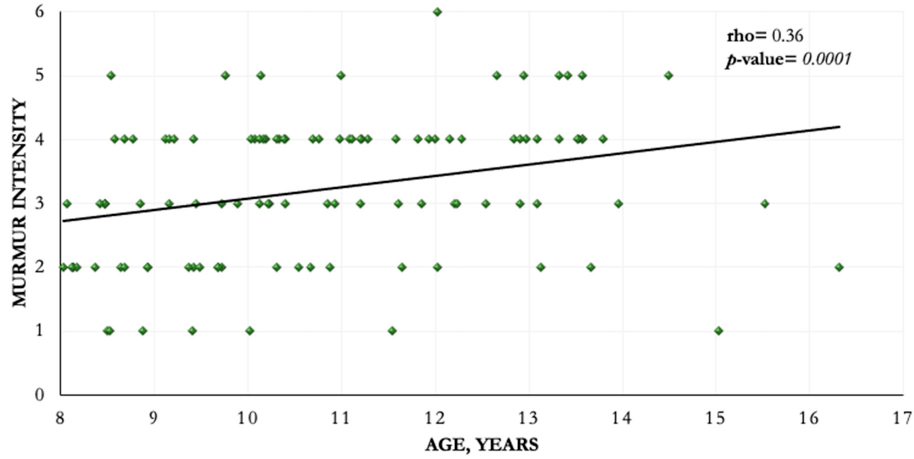
Figure 1. Correlation between murmur intensity and age. On echocardiographic examination. all 126 CKCSs (100%) were diagnosed with MMVD; 123 of them (98%) had both MR and TR. Mitral valve prolapse was evidenced in 111 dogs (88%); classified as mild in 91 (82%) and severe in 20 (18%) dogs. Fifty-six dogs (44.4%) had heart chamber sizes within normal limits, and in three of these, the owners reported clinical signs commonly seen with MMVD (cough n = 2, exercise intolerance n = 1), with one dog being treated with pimobendan. Dogs without echocardiographic signs of cardiac remodelling had a median (IQR) age of 9.7 (8.8–10.9); within them, 39 (70%) were 8–10 years old, 13 (23%) were 11–13 years old, and 4 (7%) were >13 years old (Table 3). Nine out of 56 dogs (16%) without cardiac remodelling did not have murmur on cardiac